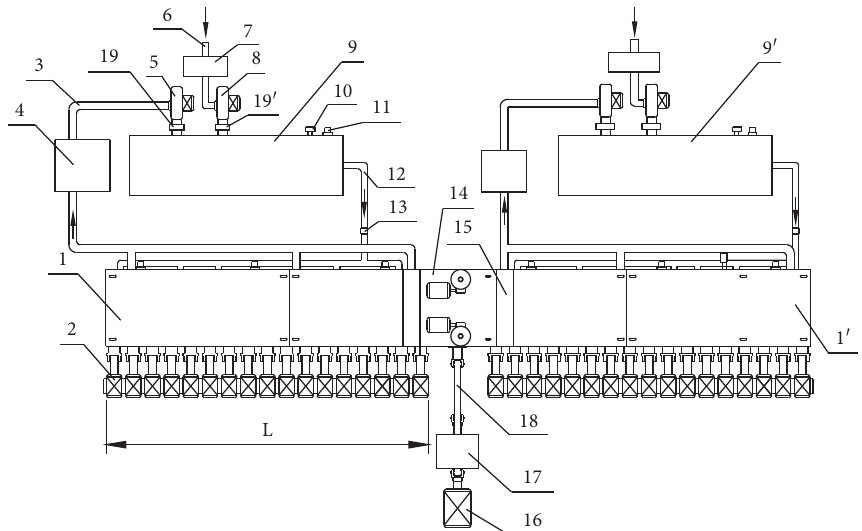
Figure 5: Top view of the hot air edge temperature compensation roller incubator for rolling magnesium alloy.1, roller table; 2, roller motor; 3, heat recovery pipe; 4, filter; 5 and 8, blower; 6, replenishment pipeline; 7, filter; 9, heat preparation box; 10, pressure sensor; 11, temperature sensor; 12, hot gas pipeline; 13, high-temperature speed control valve; 14, rolling machine; 15, heat recycle cover mounted on rolling mill; 16, rolling mill main motor; 17, speed reduction box; 18, kaleidoscope; 19, unidirectional valve.